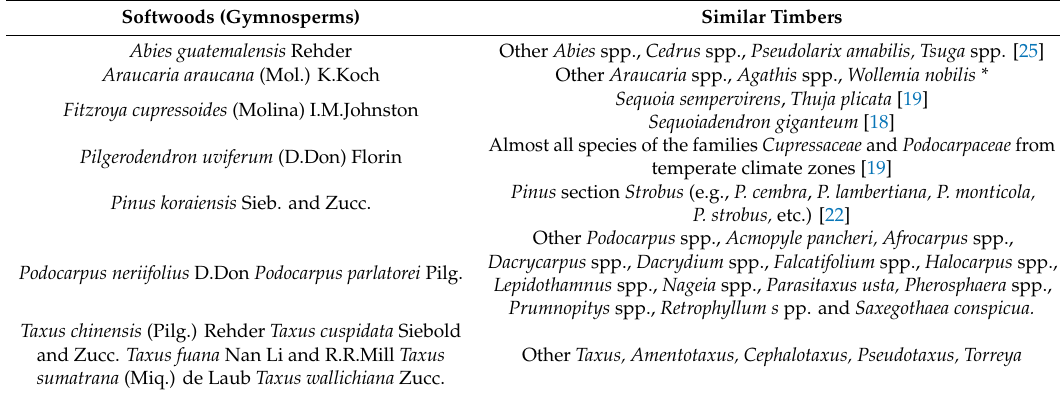
Table A1. Timbers Similar to CITES-Listed